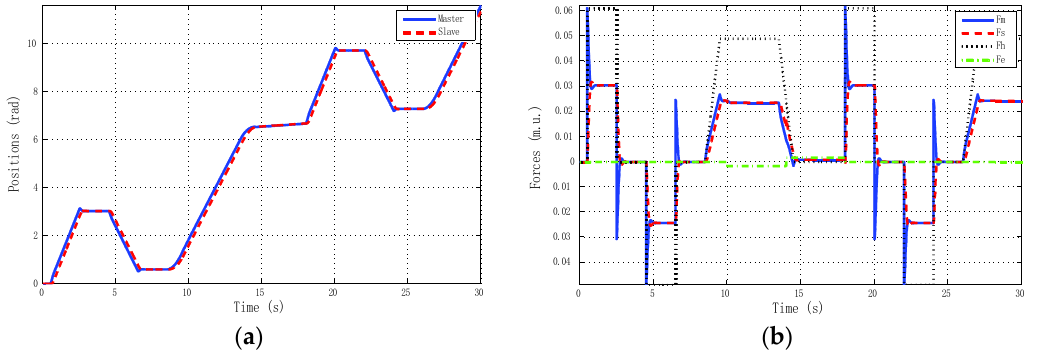
Figure 9. Simulated f h = f e = 0 with h max = 0, d = 0. Positions. ( a ) PE; ( b ) γ-4C.